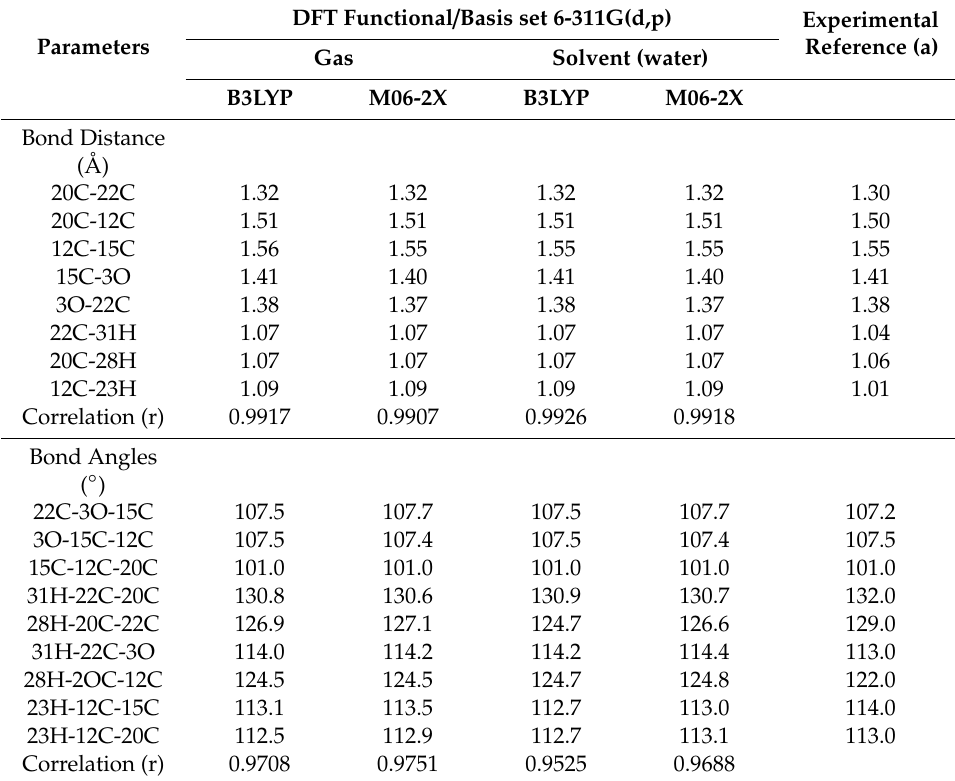
Table 1. Geometrical parameters for AFB1 calculated in the gas and solvent phases using the IEFPCM solvation model and the X-ray di ff raction data reported for the same compound.